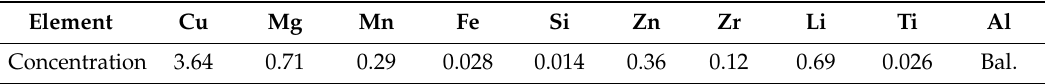
Table 1. Chemical composition table of Al-Li-S4 aluminum alloy (mass percentage, %). Element Cu Mg Mn Fe Si Zn Zr Li Ti Al Concentration 3.64 0.71 0.29